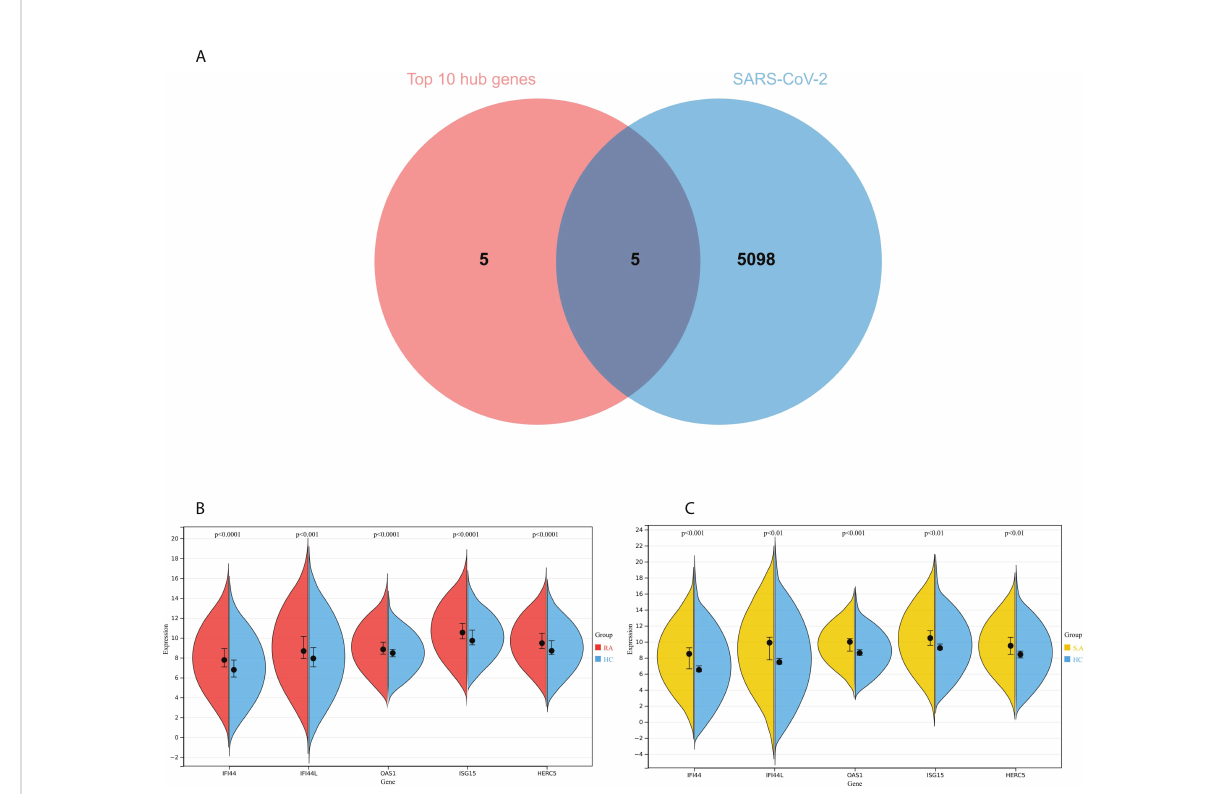
FIGURE 8 Identi fi cation of the hub gene between RA, COVID-19, and SAB. (A) Venn diagram of the top 10 hub genes and the SARS-CoV-2 gene set. (B, C) The expression of IFI44, OAS1, IFI44L, ISG15, and HERC5 in the GSE93272 and GSE33341 datasets was analyzed using split-face violin plots. Red indicates the RA group, yellow indicates the S. aureus group, and blue indicates the HC